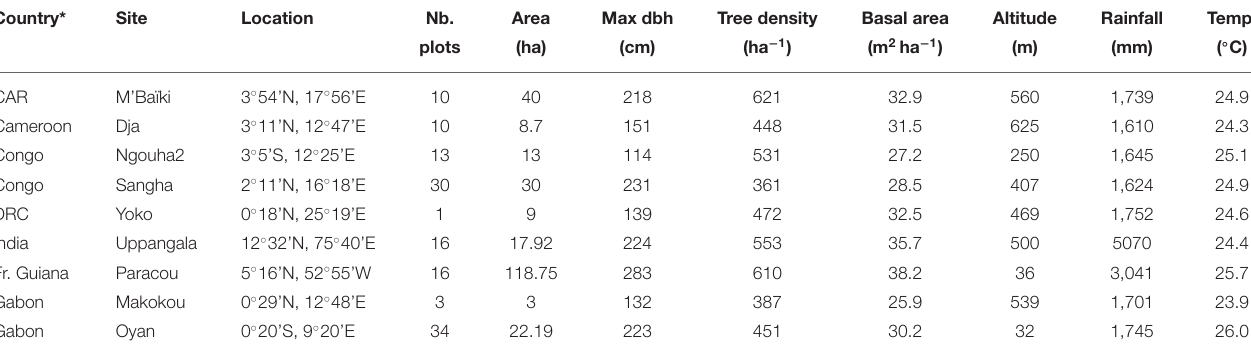
TABLE 2 | Main characteristics of the study sites in terms of sampling effort (number of plots and total inventoried area), structural attributes (maximum dbh, tree density and basal area), and environment (altitude, annual rainfall and average temperature). Country* Site Location Nb. Area Tree density Basal area Altitude Rainfall